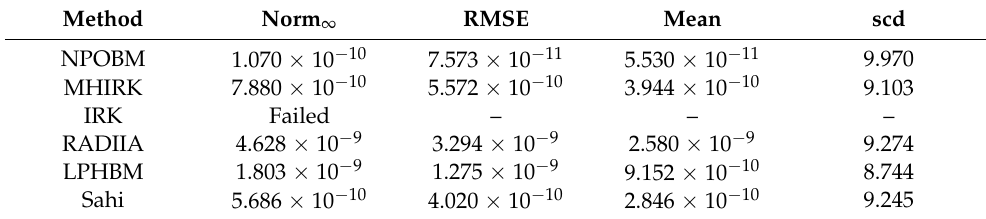
Table 18. Numerical results for Problem 5 with NS = 2 7 where x ∈ [ 0,20 ] .